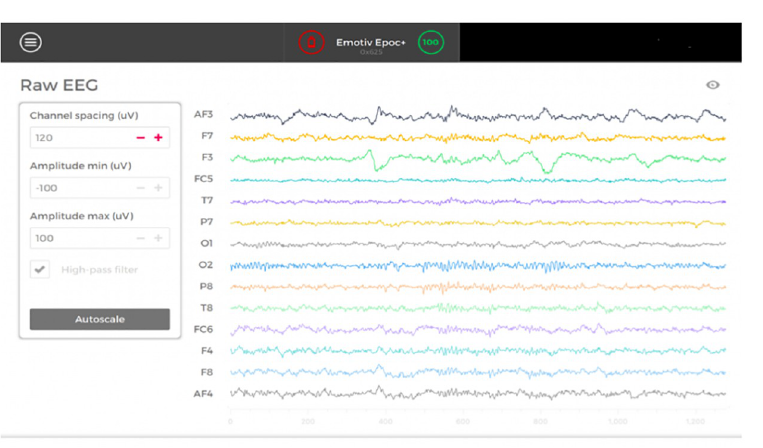
Fig 3. Raw EEG data obtained from the 14 channels of the Emotiv EPOC